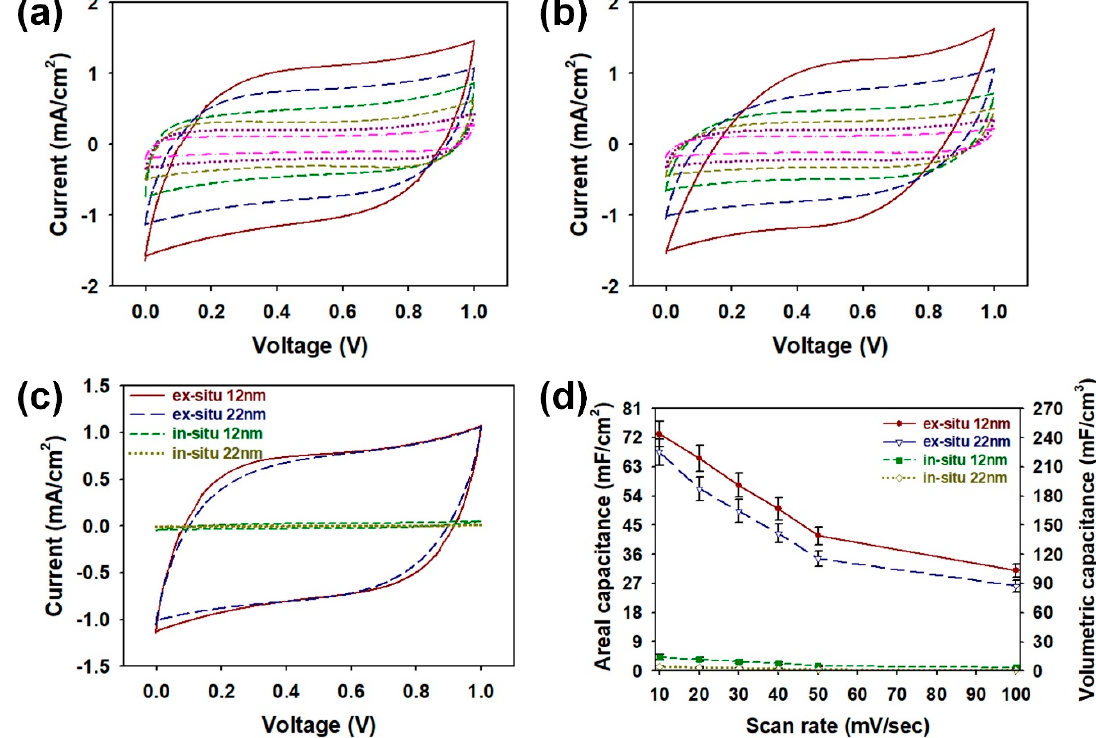
Figure 5. Cyclic voltammetry (CV) curves of coin cells containing core-shell NPs with ( a ) 12 nm and ( b ) 22 nm SiO 2 NPs prepared by ex situ method at different scan rates: 100 mV/s (red), 50 mV/s (blue), 40 mV/s (green), 30 mV/s (olive green), 20 mV/s (purple), and 10 mV/s (pink); ( c ) CV curves of coin cells containing core-shell NPs prepared by different synthetic conditions at a scan rate of 50 mV/s; ( d ) plots of areal capacitance (mF/cm 2 ) and volumetric capacitance (mF/cm 3 ) for coin cells containing core-shell NPs prepared by different synthetic conditions with increasing scan rates.